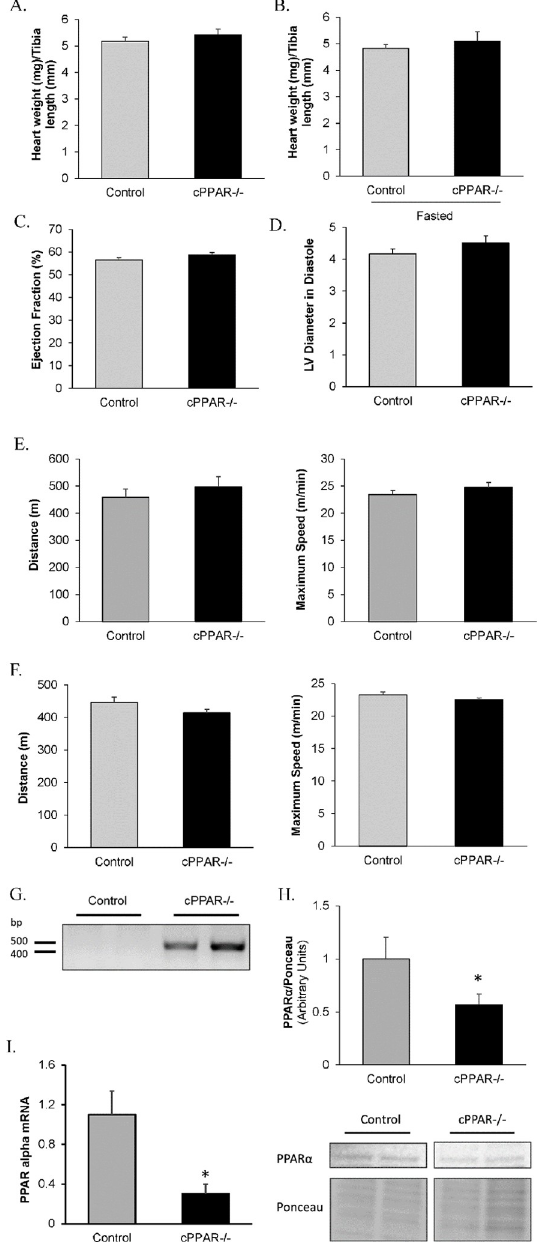
Fig 1. Reduction in cardiac PPAR α does not induce cardiac hypertrophy or reduce cardiac function. A. Hearts were weighed at baseline to assess cardiac hypertrophy. n = 12–19. B. Hearts from mice fasted for 16 hrs were weighed. n = 6–10. Heart weights were normalized to tibia length. C. Ejection Fraction and D. LV Diameter in Diastole were measured via echocardiography. n = 6. E. Exercise capacity was assessed via treadmill. n = 5–10. This was done in a single session in one day. F. Exercise capacity was assessed via treadmill in fasted mice. n = 5–6. This was done in a single session in one day. G. Genotyping of mouse tissues using genomic DNA. ~ 450 bp band indicates Mer-Cre-Mer (MCM) cut the loxp flanked sequence in the PPAR α gene. H. PPAR α protein levels were measured in hearts. n = 6–8. Representative blots are from the same membrane. I. PPAR α mRNA levels were measured in hearts. n = 4–5 Values are mean ± SEM. � p < 0.05 compared to